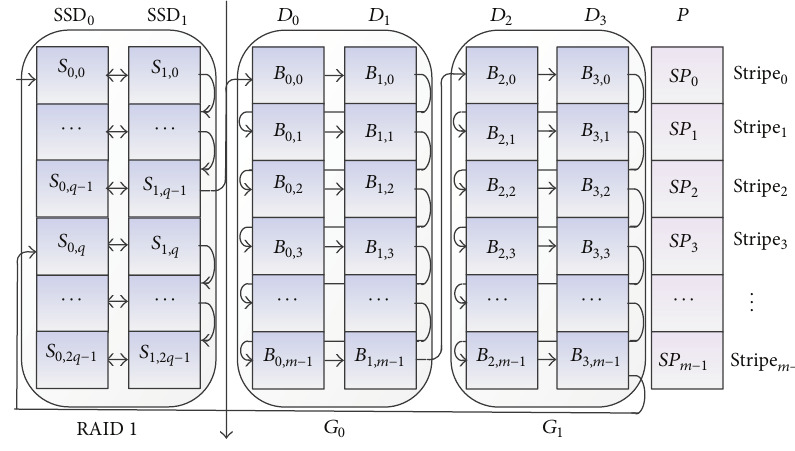
Figure 3: Data layout of HS-RAID